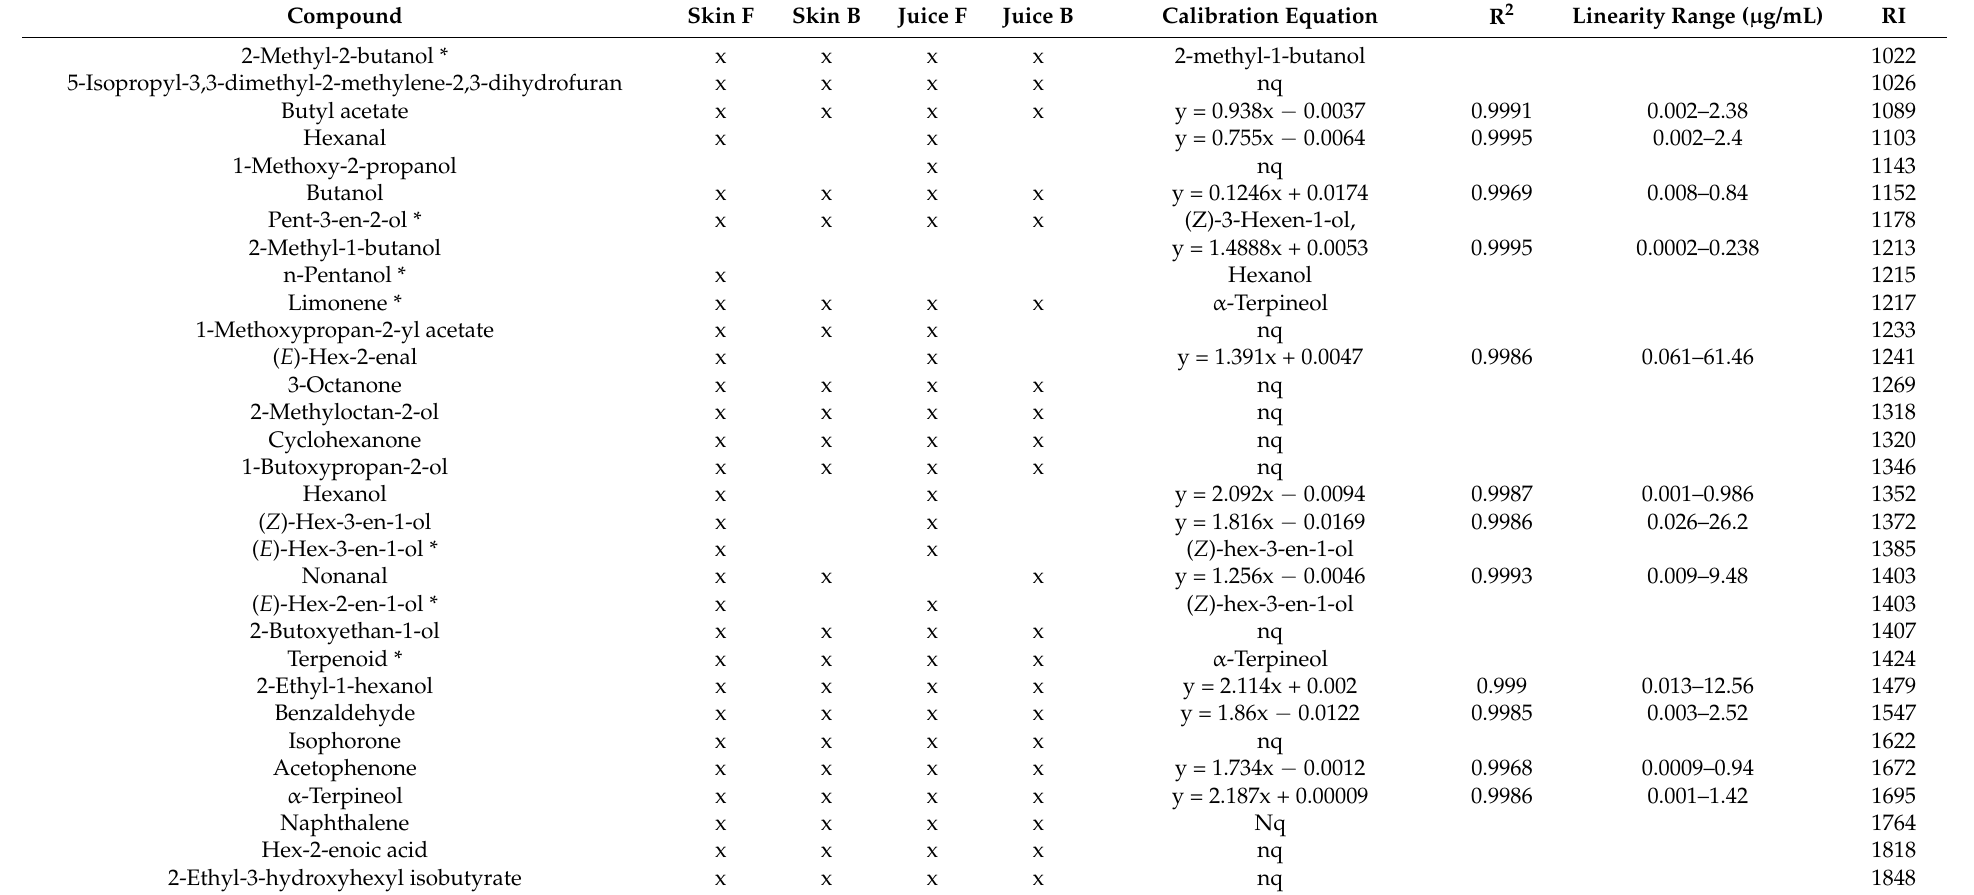
Table 2. Volatile compounds detected in the skins and juices of Cannonau grape samples from Sardinia and calibration equations used for the quantification of the volatile compounds.